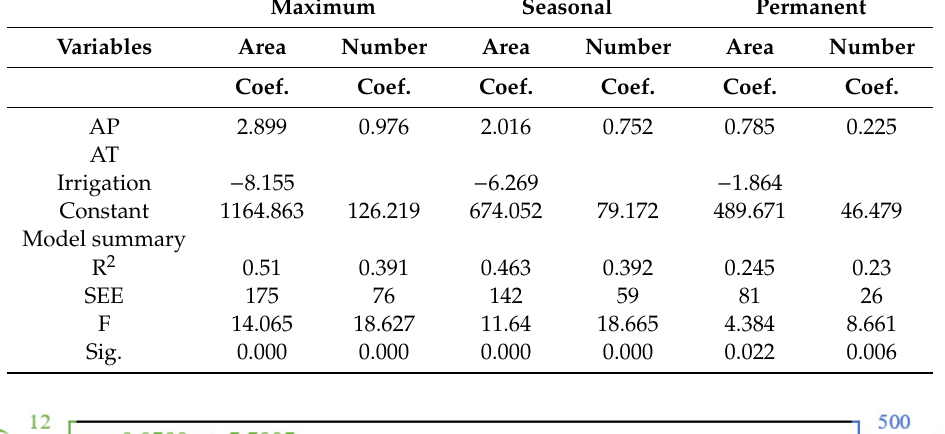
Table 4. Multiple linear regression analyses of the water body area and water body number with climatic and anthropogenic driving factors in the Hetao Plain. The six dependent variables are maximum water body area, maximum water body number, year-long water body area, year-long water body number, seasonal water body area, and seasonal water body number. AP and AT are the Hetao Plain annual cumulative precipitation and annual average temperature respectively, the three dependent variables are AP, AT, and Irrigation. R 2 is the proportion of variance in the dependent variable, which can be explained by the selected explanatory variables. SEE is the standard error of the estimate. F and Sig. are the F-statistic and the p-value associated with it. For each linear regression, the variables were statistically significant (P < 0.05).